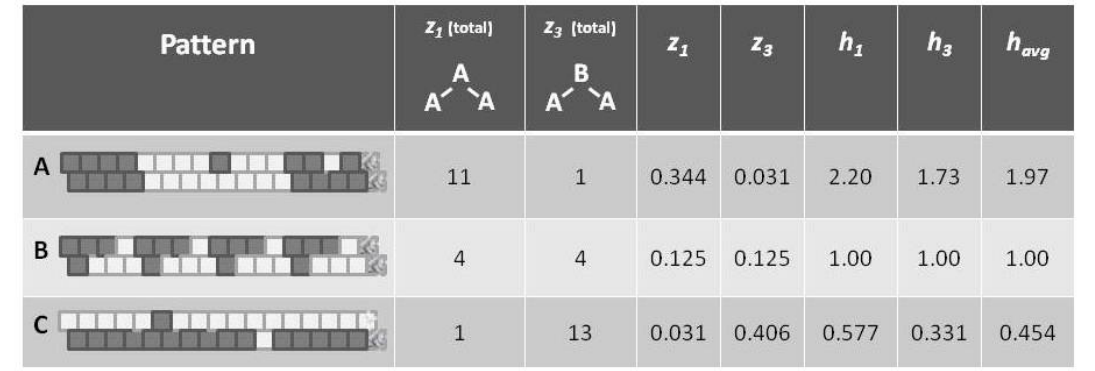
Figure 5. The previously-shown three patterns (A–C), as shown in Figure 1, can be characterized by their total values for Z 1 and Z 3 and their resulting fractional values, z 1 and z 3 . Specific values for h correspond to each z i value. The resulting h 1 and h 3 values for a given pattern may differ, as they correspond to z i values for systems that are not at equilibrium. The h i values are averaged to produce h avg